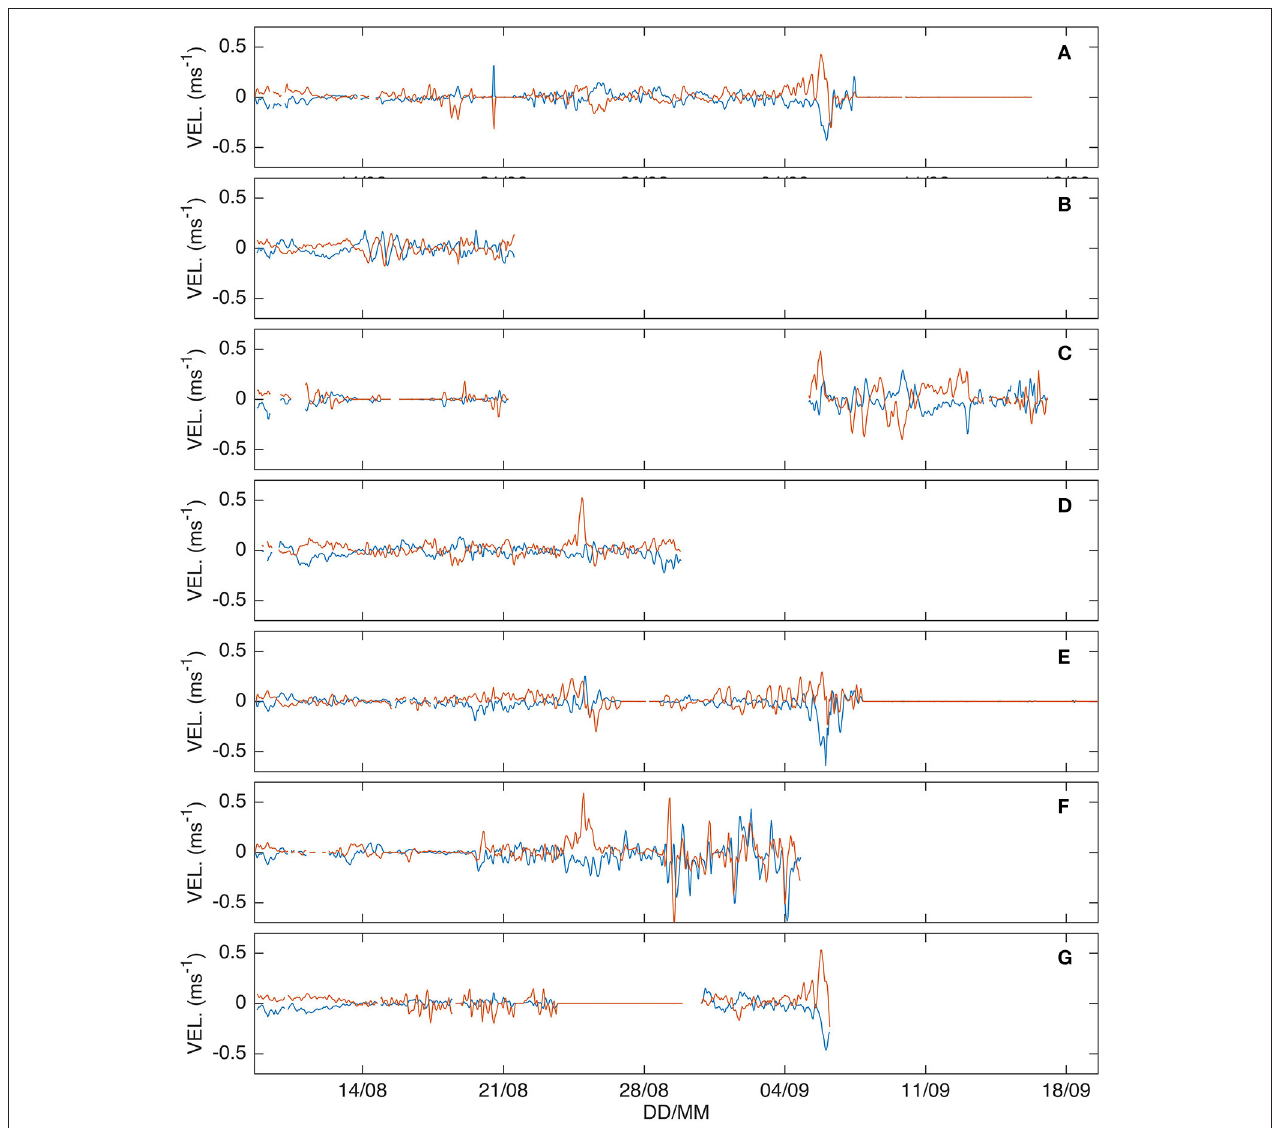
FIGURE 11 | Zonal (blue) and meridional (red) velocity components for each EXITE beacon.